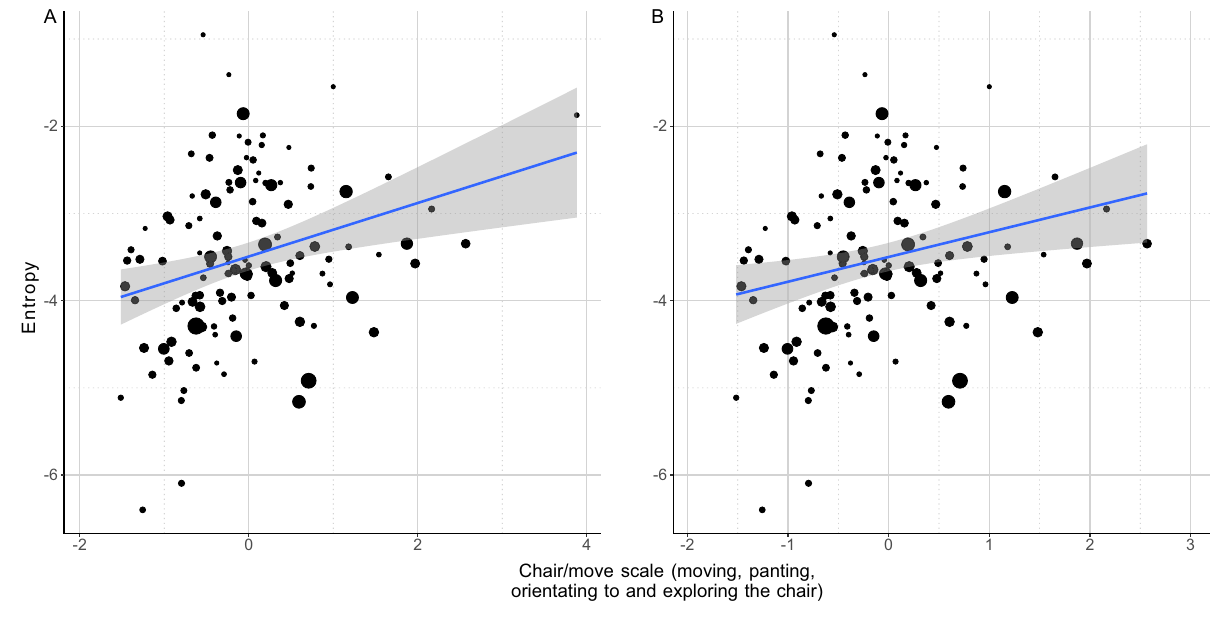
Figure 7. The positive relationship between the entropy of whines produced by the dog during the separation test and the amount of time spent with moving panting and chair directed behaviours. The size of the dots is proportional with the number of whines produced. The grey field shows the 95% confidence interval of the linear fit.